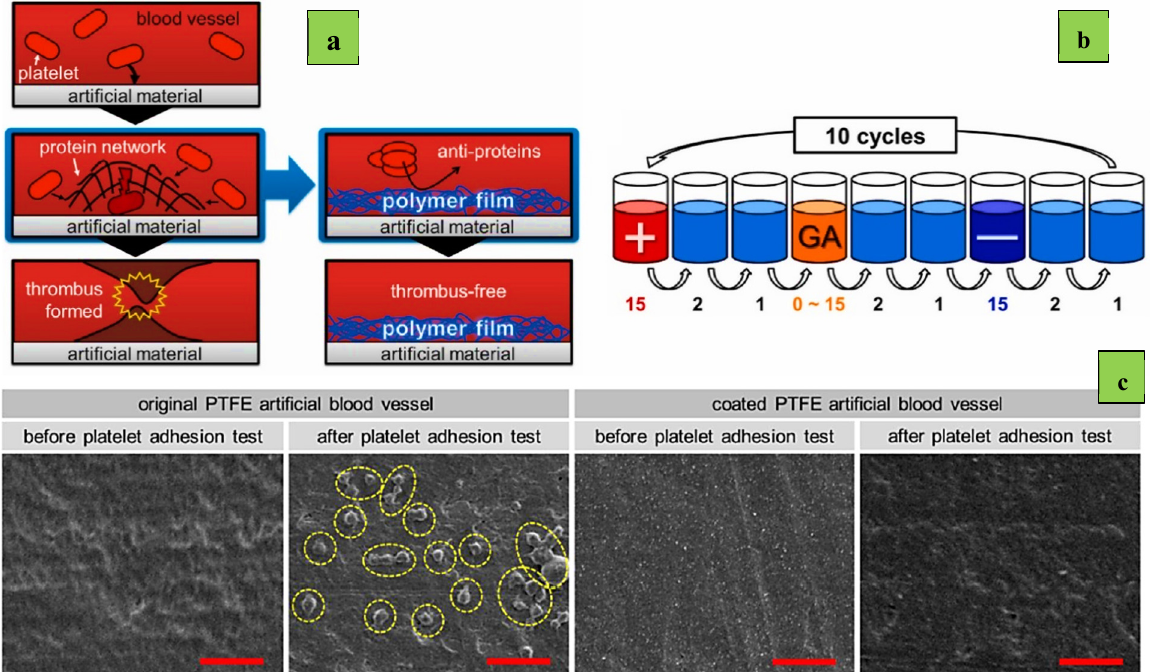
Figure 5. Schematics of ( a ) simplified thrombus formation; ( b ) the process of layer-by-layer self- assembly in the present study; ( c ) scanning electron microscopy [8] images of an uncoated original and a coated PTFE artificial blood vessel before and after the platelet adhesion test. Research was carried out by Kengo Manabe and Hidefumi Nara [51].